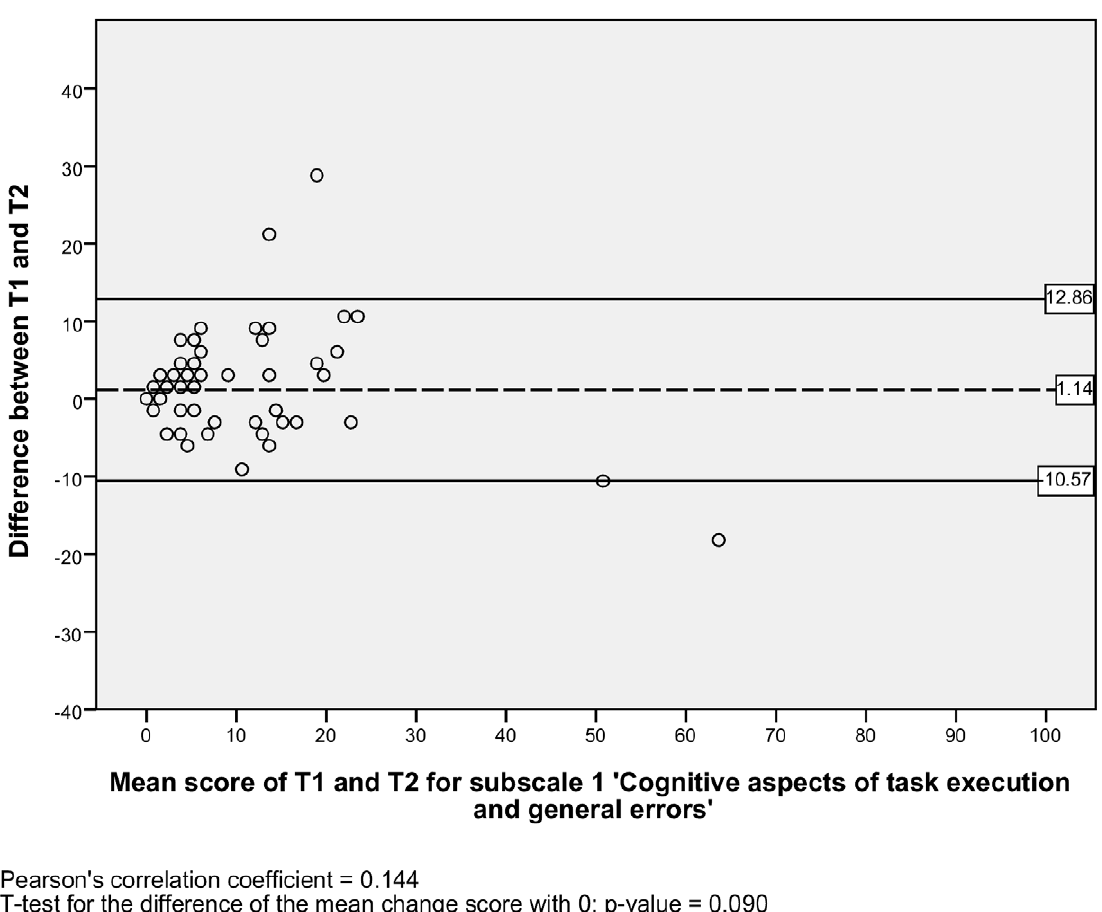
Figure 1. Bland and Altman plot for subscale 1 ‘Cognitive aspects of task execution and general incidents’.